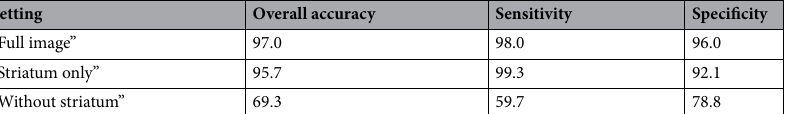
Table 1. Overall accuracy, sensitivity, and specificity of the CNN-based classification of the 123 I-FP-CIT SPECT images in the test